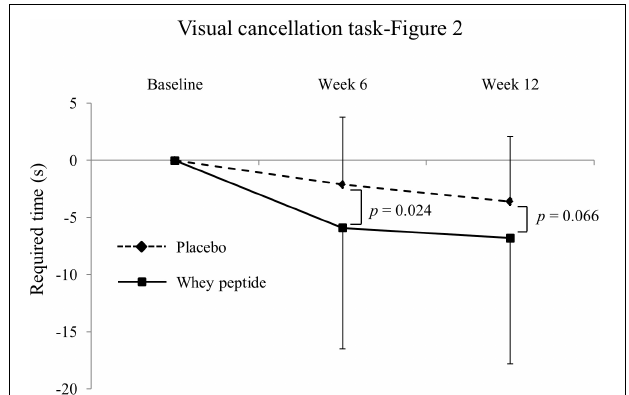
FIGURE 3 | Changes of required time in visual cancelation task-Figure 2 from baseline. The solid line shows the whey peptide group ( n = 51), and the dashed line shows the placebo group ( n = 53). The data are presented as the mean with SD. The p -value shows the results of between-group comparison, performed by unpaired t -test. p < 0.05 was considered as significant